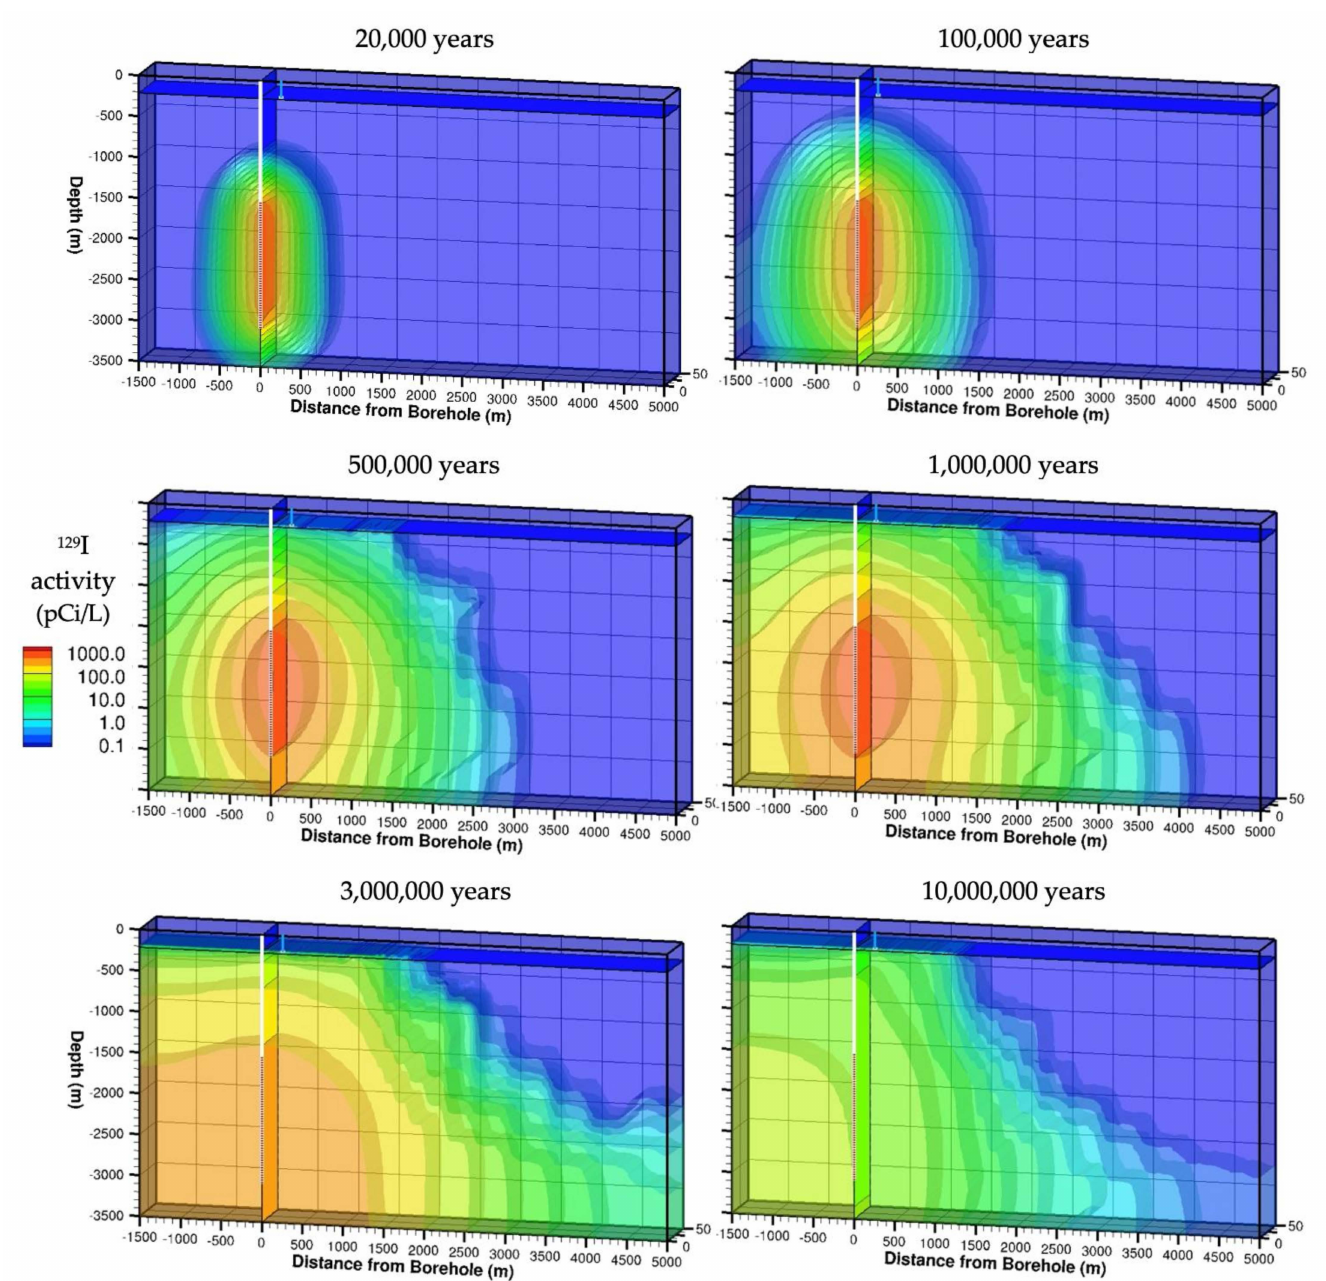
Figure 6. Simulated distribution of 129 I activity in fracture continuum at select times. A vertical slice along the borehole and a horizontal slice along the bottom of the aquifer highlight the radionuclide distributions at these locations of interest. The borehole diameter is exaggerated by a factor of